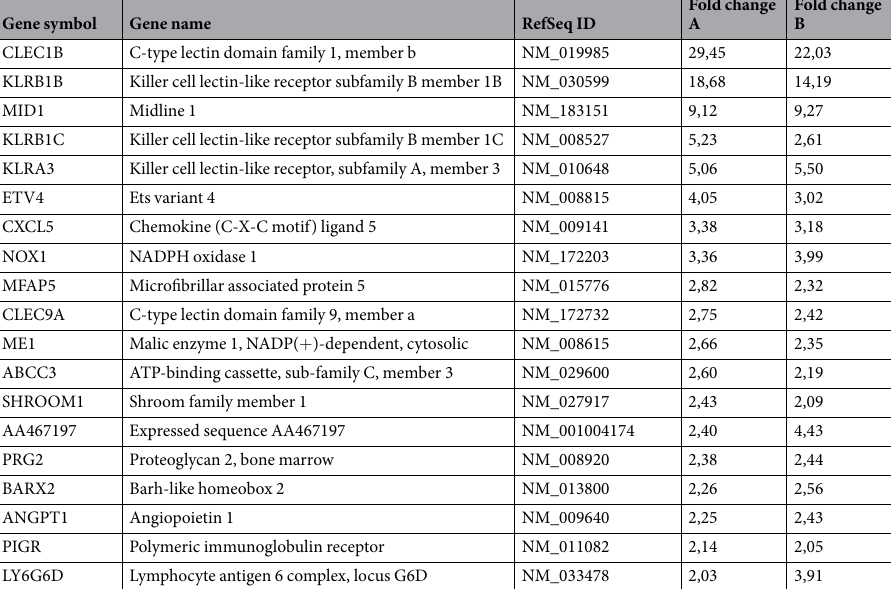
Table 4. List of upregulated genes as identified by RNA-seq in C57BL/6 WT uninfected control mice versus C57BL/6 IL-17RA KO uninfected control mice (A) and that also differentially respond upon infection